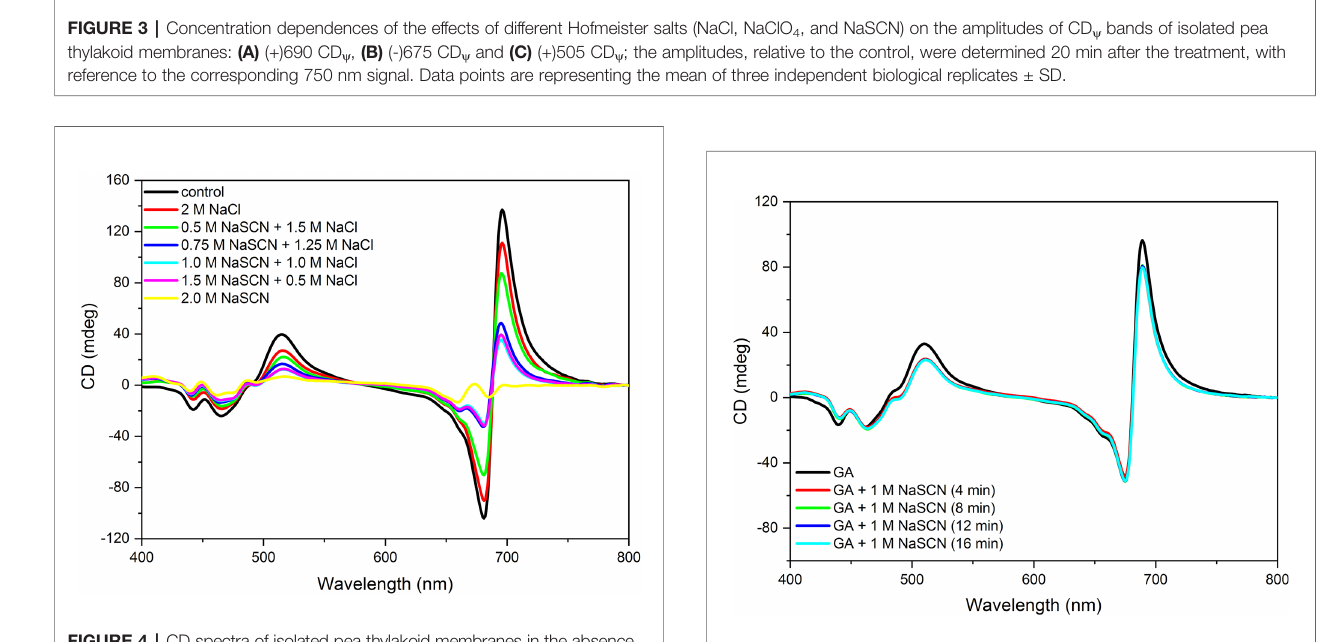
FIGURE 5 | CD spectra of isolated pea thylakoid membranes fi xed for 1 min with 2% glutaraldehyde (GA) and spectra of GA- fi xed membranes treated with 1 M NaSCN and recorded at different times after the GA fi xation. The spectra are normalized to the red absorbance maximum [OD(680 nm)=1.0] of the GA- treated sample. Note that the 4, 8, 12, and 16 min traces overlap. Three independent biological replicates were measured and a typical data set is shown.